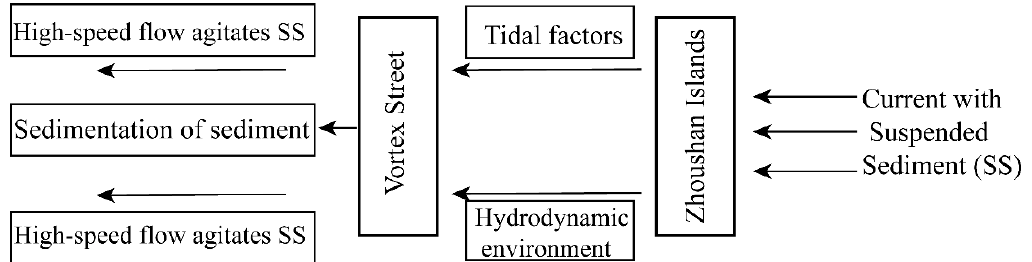
Figure 6. Graphical abstract illustrates the impacts of Zhoushan Islands on suspended sediment distribution. When currents with suspended sediment pass through the Zhoushan Islands, forming the vortex street under the influence of tidal factors and hydrodynamic environment. The high-speed flow of the seawater agitates the suspended sediment to float outside the vortex while the central sediment is settled. Resulting the SSC increases, decreases, increases and repeating the change downstream the islands.